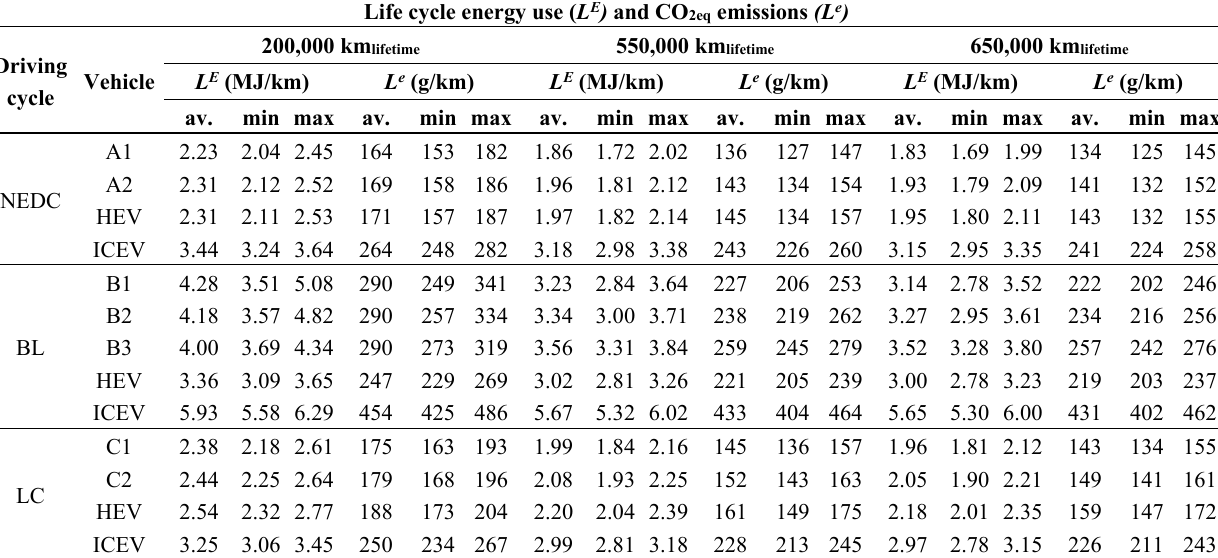
Table 9. Life cycle energy use and CO 2eq emissions regarding the optimal solutions and the reference powertrains, for the different driving cycles (NEDC, BL, LC) and lifetime distances.